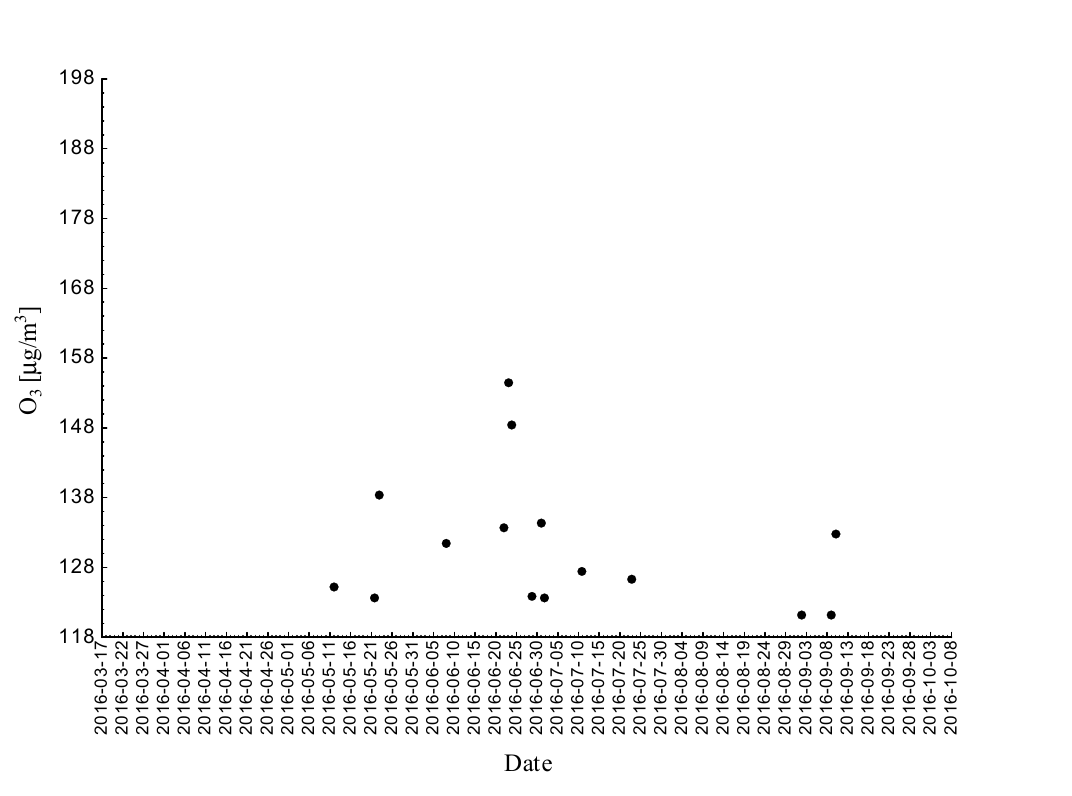
Figure 6. Maximum daily 8-h mean ozone concentration not less (equal to or more than) than 120.4 µg/m 3 registered at the measurement station in Katowice (SL09KA) in 2016.